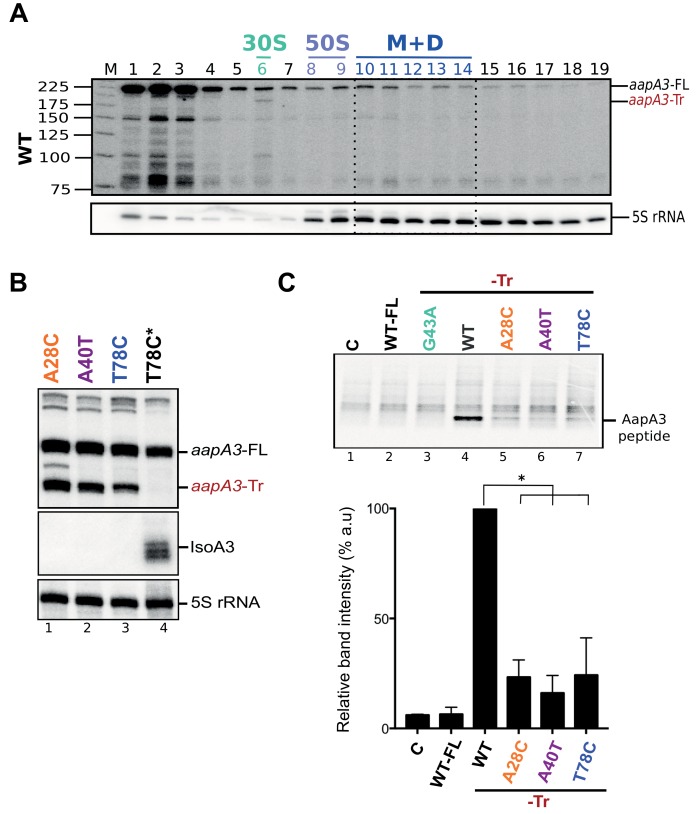
The A28C, A40T and T78C suppressors inhibit aapA3-Tr mRNA translation.(A) Only the 3’ end truncated aapA3 mRNA form is translated in vivo. Cell lysate of the H. pylori 26695 wild-type (WT) strain was subjected to ultracentrifugation through a sucrose gradient. A profile of OD254nm was recorded. RNA was extracted from each fraction and equal volumes of each extract were subjected to Northern Blot analysis. Fractions corresponding to the free 30S and 50S subunits, 70S ribosomes (free and translating) and polysomes are indicated. The different transcripts are annotated as: aapA3-FL (full length, 225 nt), aapA3-Tr (3’ end truncated, 190 nt), and 5S rRNA as loading control (5S rRNA). M, monosomes; D, disomes. (B) Gene expression analysis of the indicated strains was analyzed by Northern Blot. Transcripts aapA3-FL (full length), aapA3-Tr (3’ end truncated), and IsoA3 full-length and processed transcripts are shown. Proper loading was assessed by the level of 5S rRNA. The T78C* construct contains a WT IsoA3. (C) Relative peptide production upon in vitro translation of aapA3-FL, aapA3-Tr and the aapA3-Tr form of the three independent suppressor mutants A28C-Tr, A40T-Tr and T78C-Tr (upper panel). A construct with inactivated SD sequence (G43A-Tr) was also included for comparison. Control lane (0) shows the translation background obtained without exogenous mRNA. A representative experiment is shown. Relative peptide production was quantified (lower panel). Error bars represent the s.d; n = 3 technical replicates, *p<0.0001 according to unpaired t-test. Peptide production using the G43A-Tr control RNA was not quantified as the experiment was performed only once. Figure 4—figure supplement 2—source data 1.10.7554/eLife.47549.013Figure 4—figure supplement 2—source data 1.Numerical values of the 3 replicates of the in vitro translation assays shown in Figure 4—figure supplement 2.